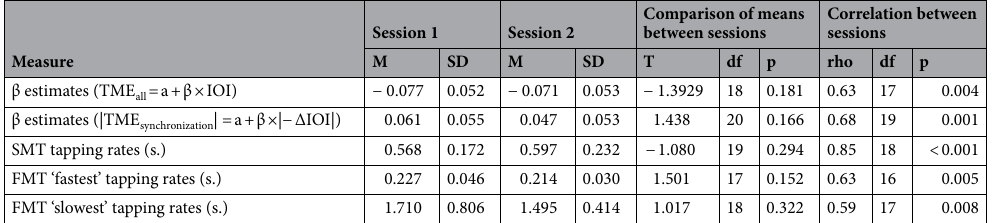
Table 1. Single session descriptive statistics of measures and test results for between-session comparisons.